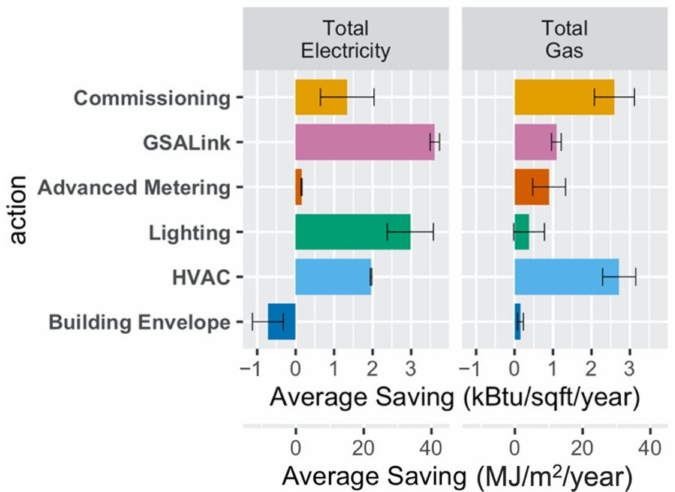
Figure 7. Bar chart of the mean and 95% C.I. of the estimated retrofit effects of past retrofit actions. Table 5. The distribution of the estimated site electricity or gas EUI in kBtu/sqft/year savings among retrofitted